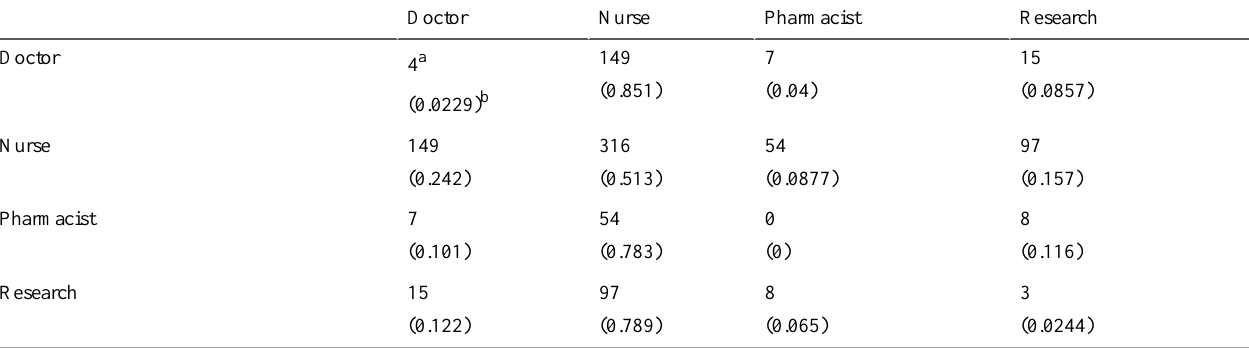
Table 5. The interoccupation